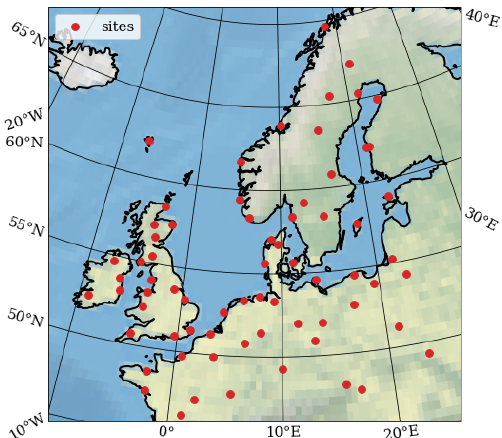
Figure 3. Map of northern Europe indicating the locations of the sites used for training (seven in total, anonymized) and testing (99 in total). Made with Natural Earth.